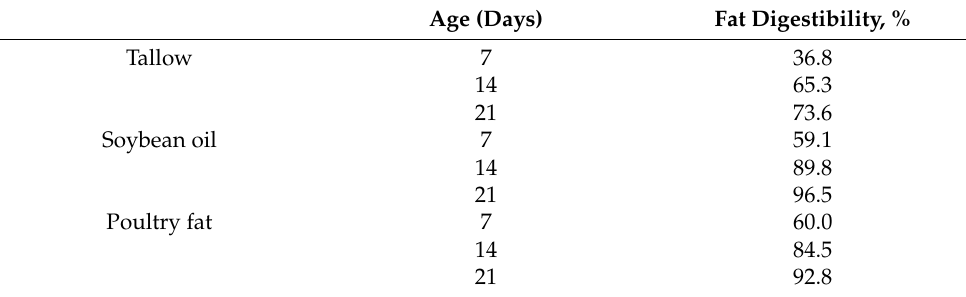
Table 1. Influence of broiler age on the total tract fat digestibility in three fat